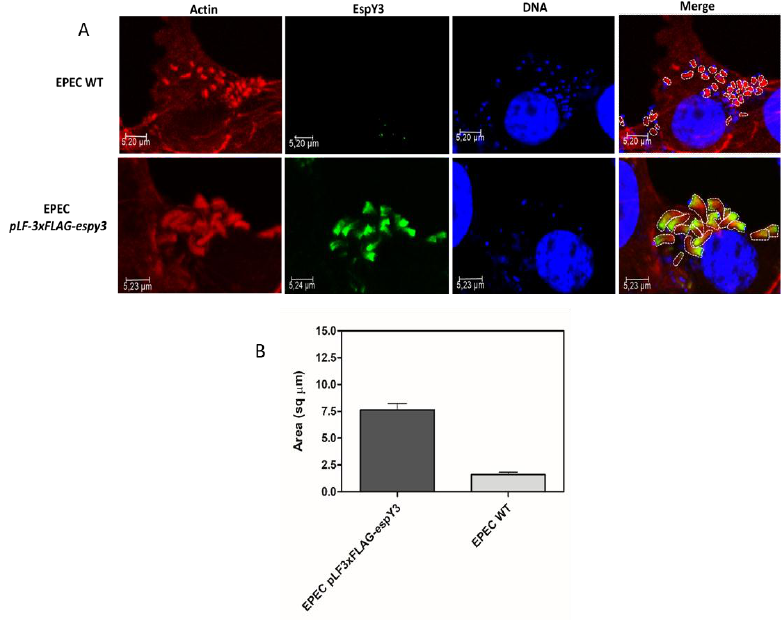
Figure 4. Calculation of the pedestals areas. ( A ) The Image J software was used to delineate and calculate the pedestals area generated by EPEC WT and EPEC pLF-3xFLAG-espy3 on infected Caco-2 cells. The polymerized cellular actin was stained with Rhodamine-phalloidin (Red), the eukaryotic nuclei and bacterial DNA with TO-PRO-3 (Blue), and EspY3 protein was detected using anti-FLAG mouse specific antibodies and Alexa 488 conjugated goat anti-mouse IgG as secondary antibody (Green) (ZOOM 3). ( B ) The graph represents the significant difference ( p < 0.05) in the increase of the pedestals formed by the translocation of EspY3.